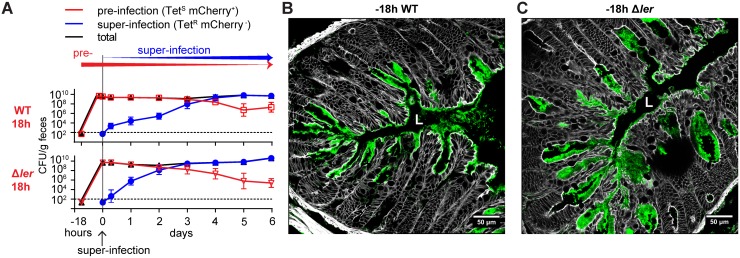
Ongoing A/E lesion induction in mice deficient for innate signaling through MyD88 and Trif.(A) Colonic colonization dynamics in MyD88-/-Triflps/lps germ-free mice consecutively infected, first with mCherry+ KanR TetS
C. rodentium wild type (WT) or an isogenic Δler mutant (1010 CFU, red squares and triangles), and 18 hours later superinfected with mCherry- KanS TetR
C. rodentium wild type (104 CFU, blue circles). Total C. rodentium counts are depicted as black symbols. Connecting lines connect means; error bars indicate standard deviation; horizontal dotted lines indicate detection limit. (B and C) Representative fluorescent microscopy images of distal colon of MyD88-/-Triflps/lps mice shown in panel A pre-infected with wild type (B) and Δler (C) C. rodentium, respectively. Grey, F-actin/phalloidin; green, anti-Citrobacter O-antigen antibody (pre-infection strain and superinfecting strain); red, mCherry-expressing C. rodentium (pre-infection strain only; none detectable). Scale bars: 50 μm.